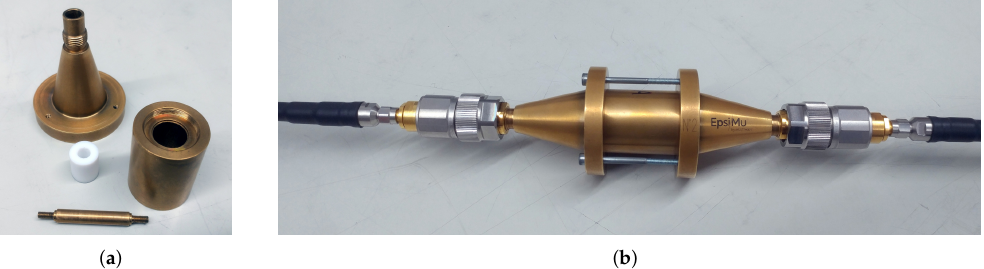
Figure 2. Coaxial transmission line, MUT, and connection with the network analyser. ( a ) Coaxial taper, sample holder (outer conductor) with PTFE material sample, and inner conductor; ( b ) assembled device with adaptors connected to the network